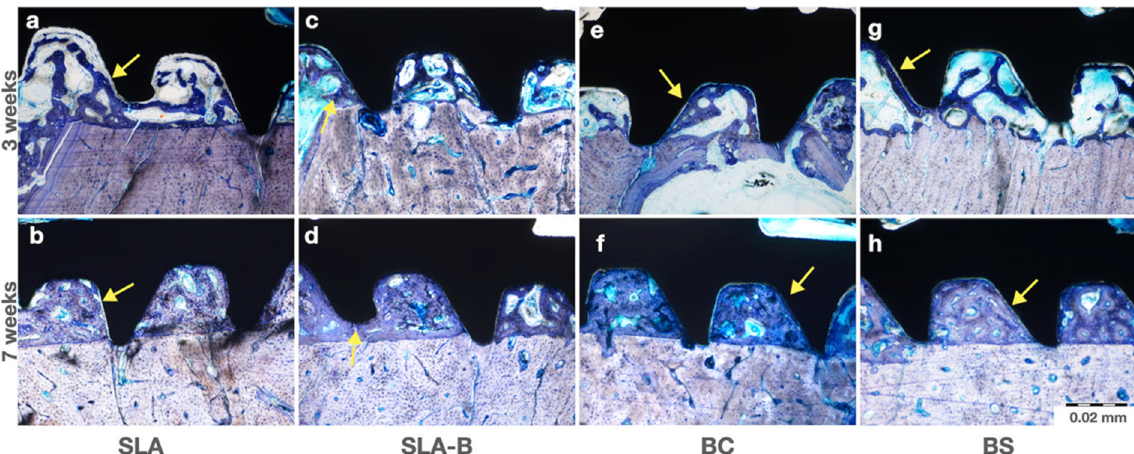
Figure 11. Representative histologic images of toluidine blue-stained sections in each group. Images obtained from the middle region of the implants. ( a ) The osteoid layer deposited between the old matrix and the implant surface (arrow). ( b ) The bone matrix deposition in direct contact with the surface was observed (arrow). ( c ) Active osteoid depositions were detected (arrow). ( d ) The new matrix deposition was completed; the arrow pointed to the contact line between the old and new bone matrices (arrow). ( e ) Line of osteoid deposition is also shown (arrow). ( f ) An organized bone matrix (arrow) with new matrix deposition (arrowhead) was determined. ( g ) Bone matrix deposition was evident on the implant surface (arrow). ( h ) New bone formation almost completely filled within the implant threads (arrow) (toluidine blue, original magnification ×200).